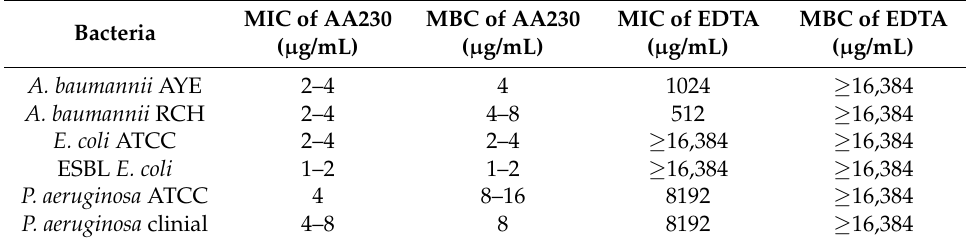
Table 1. Minimum inhibitory concentrations (MICs) and minimum bactericidal concentrations (MBCs) of antimicrobial peptide AA230 and EDTA (ethylenediaminetetraacetic acid) against different strains of P. aeruginosa , A. baumannii and E. coli . MICs and MBCs are expressed in µg/mL.